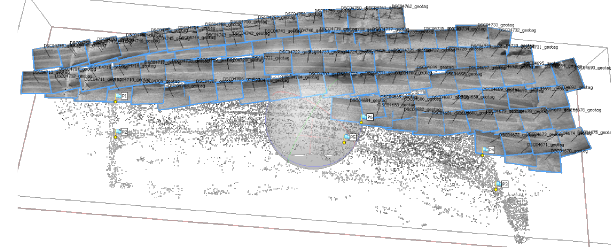
Figure 9. Aerial block configuration.